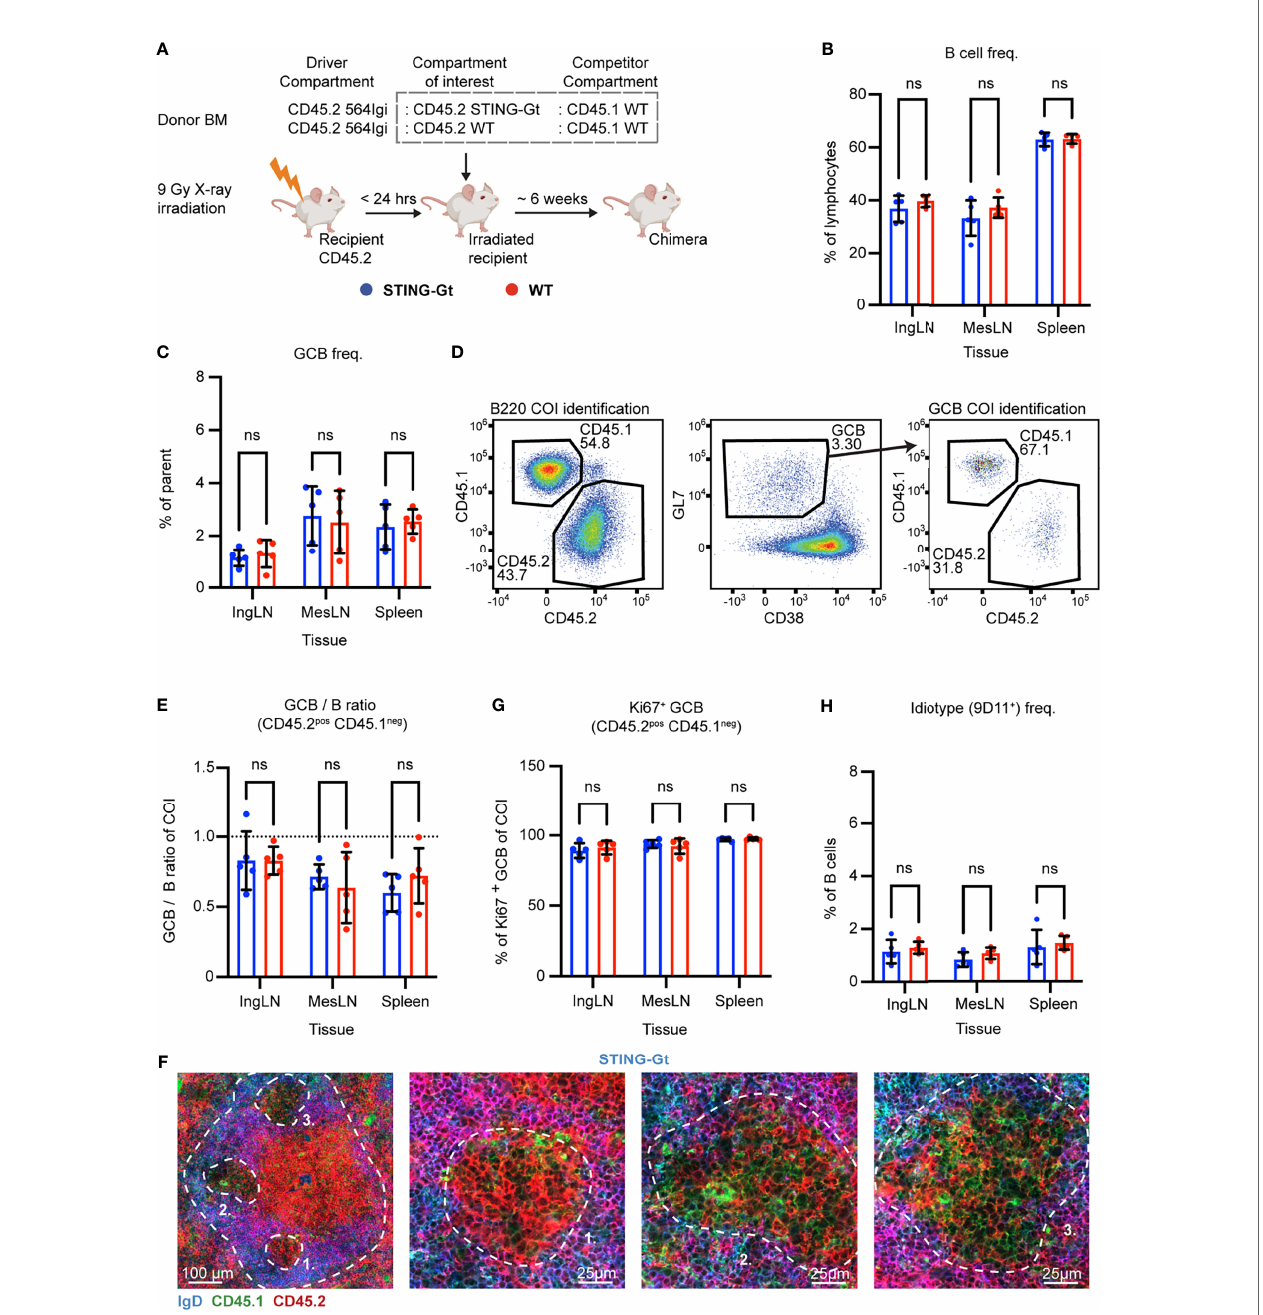
FIGURE 2 | B cell intrinsic STING signaling is not required for autoreactive germinal center participation. (A) Schematic overview of experimental setup with timeline. (B) B cell frequencies out of live, singlet lymphocytes, in lymphoid tissues of STING-Gt (blue, n = 5) and WT (red, n = 5) chimeras. Each dot represents an individual mouse and bars indicate mean +/- SD, with statistical signi fi cance given for two-way ANOVA followed by Sidak ’ s post-test ( a = 0.05), ns = not signi fi cant. (C) As in (B) , but for GCB cell frequencies instead. (D) Representative example from a STING-Gt chimera showing gates used to de fi ne CD45.2 vs. CD45.1 within the B cell (left) and GCB cell (right) compartments, and the parent GCB cell gate (center). (E) As (B) but showing relative GCB to B cell ratios for the compartment of interest (COI, CD45.2 + CD45.1 - ). (F) Confocal micrographs of spleen sections from a representative STING-Gt chimera stained for IgD (naïve B cells, blue), CD45.1 (green), CD45.2 (red) and the marginal zone (CD169, not shown). Left, lower magni fi cation image, with indication of the marginal zone (broken white line, based on CD169 staining, Figure S2G ) and three GCs (numbered). Subsequent panels present higher magni fi cation images of each of the three numbered GCs in the left panel. Channel assignments and brightness were adjusted to enhance visual clarity of micrographs. (G) As (B) , but for Ki67 positive frequency within the GCB cell compartment of interest (COI, CD45.2 + CD45.1 - ). (H) As (B) , but for 564Igi idiotype (9D11 + ) frequencies of B